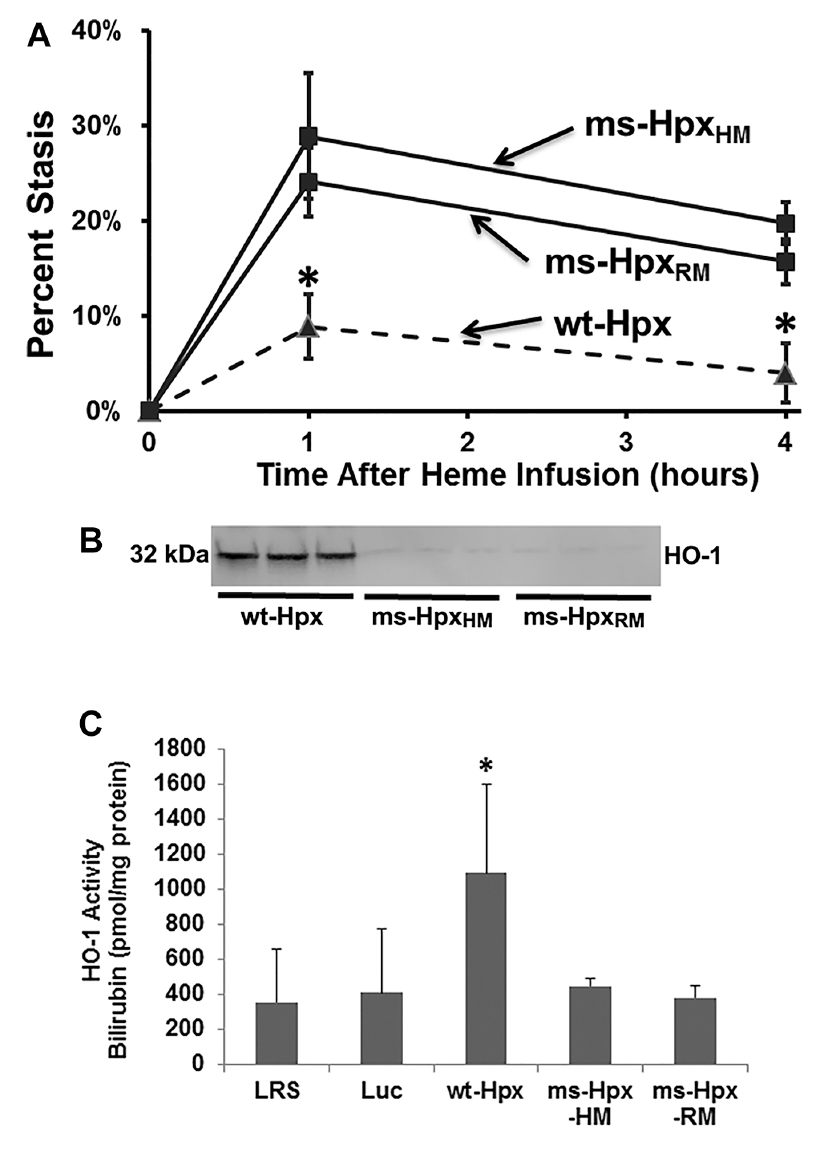
or ms-Hpx decreased heme-induced stasis and in- Figure 7. Wt-Hpx but not ms-Hpx HM RM creased HO-1, and was not protective when HO-1 was blocked by SnPP. (A) NY1DD mice were hydrodynamically infused with SB 100X + wt-Hpx (n = 4), SB 100X + ms-Hpx (n = 3) or HM SB 100X + ms-Hpx (n = 4) plasmids. DSFCs were implanted 4 wks later and microvascular RM stasis was measured at 1 h and 4 h after infusion of heme (3.2 μ mols/kg). Percentage of stasis (mean ± SD) was calculated at each time point. * p < 0.05 for wt-Hpx compared with ms-Hpx and ms-Hpx . P < 0.05 for comparison of wt-Hpx to ms-Hpx or ms-Hpx HM RM HM RM (B) Liver microsomes were immunostained for HO-1 (32 kDa). (C) HO activity was mea- sured in liver microsomes 4 wks after NY1DD mice were hydrodynamically infused with LRS (n = 4), SB 100X + Luc (n = 4), SB 100X + wt-Hpx (n = 4), SB 100X + ms-Hpx (n = 3) or HM (n = 4). P < 0.05 for comparison of wt-Hpx to LRS, Luc, ms-Hpx or ms- SB 100X + ms-Hpx RM HM Hpx . (D) Treatment of NY1DD sickle mice overexpressing wt-Hpx with the HO inhibitor RM tin protoporphyrin (SnPP, 40 μ mols/kg × 3 d, intraperitoneally) reversed the protection af- forded by wt-Hpx. * P < 0.05 for comparison of wt-Hpx to wt-Hpx + SnPP. The wt-Hpx data (dashed line) in A and D were taken from Figure